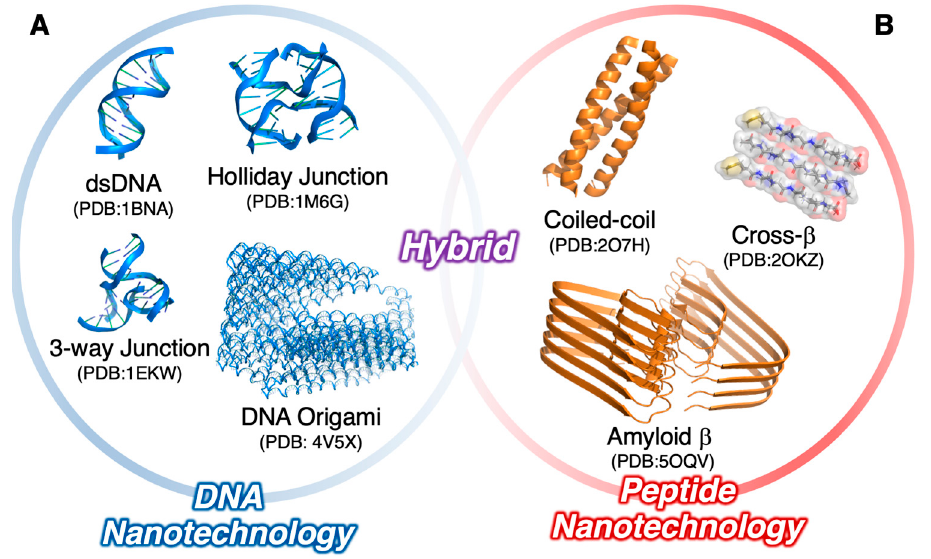
Figure 1. ( A ) DNA and ( B ) peptide nanotechnologies. Representative supramolecular architectures (nanostructures) and their typical component structural motifs are shown.